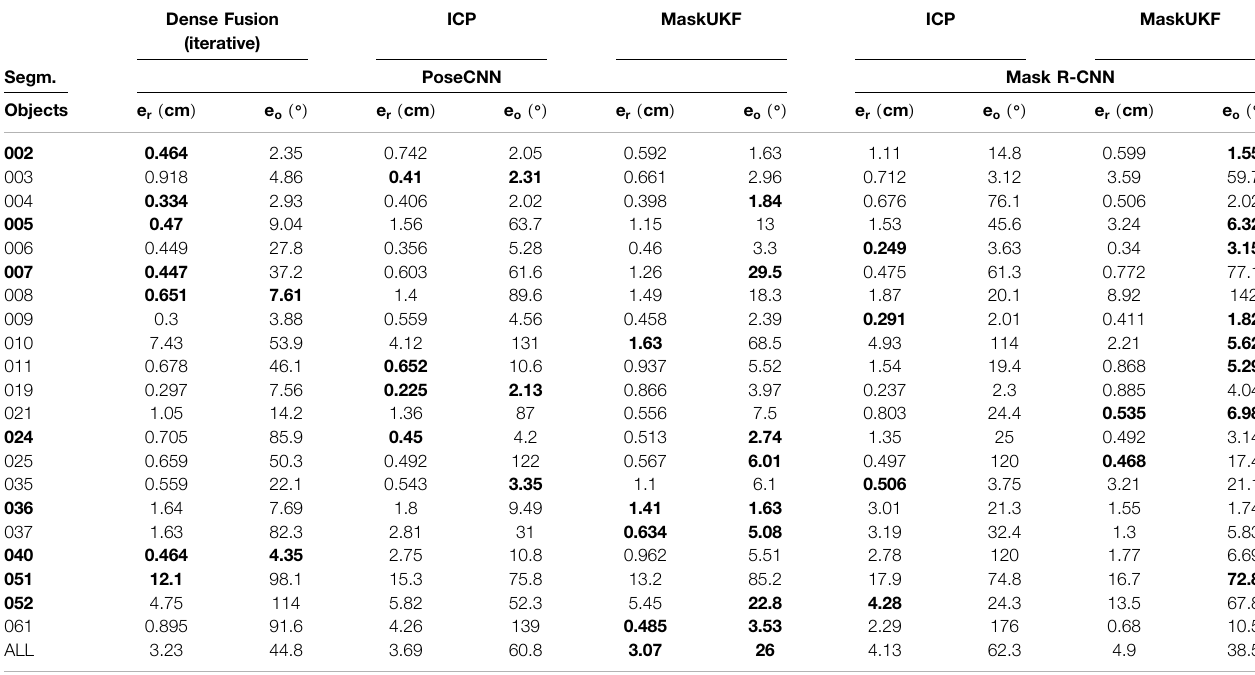
TABLE 2 | Quantitative evaluation of 6D pose on all frames of YCB-Video Dataset (RMSE). Objects in bold are considered symmetric. In this experiment, segmentation masks are available at each frame I t . Aboldentry indicatesa strictlybetterresult(i.e.ifdifferent algorithmshavethe samebestresult, the associatedentries arenot bolded). Dense Fusion ICP MaskUKF ICP MaskUKF (iterative) Segm. PoseCNN Mask R-CNN